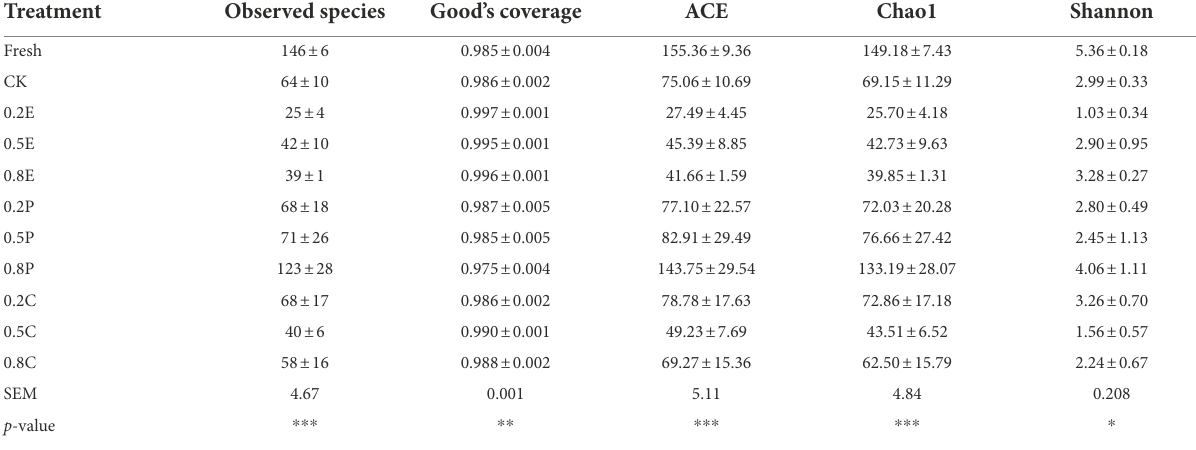
TABLE 6 Diversity and richness of bacterial microbiota of paper mulberry ensiled with different treatments during fermentation.